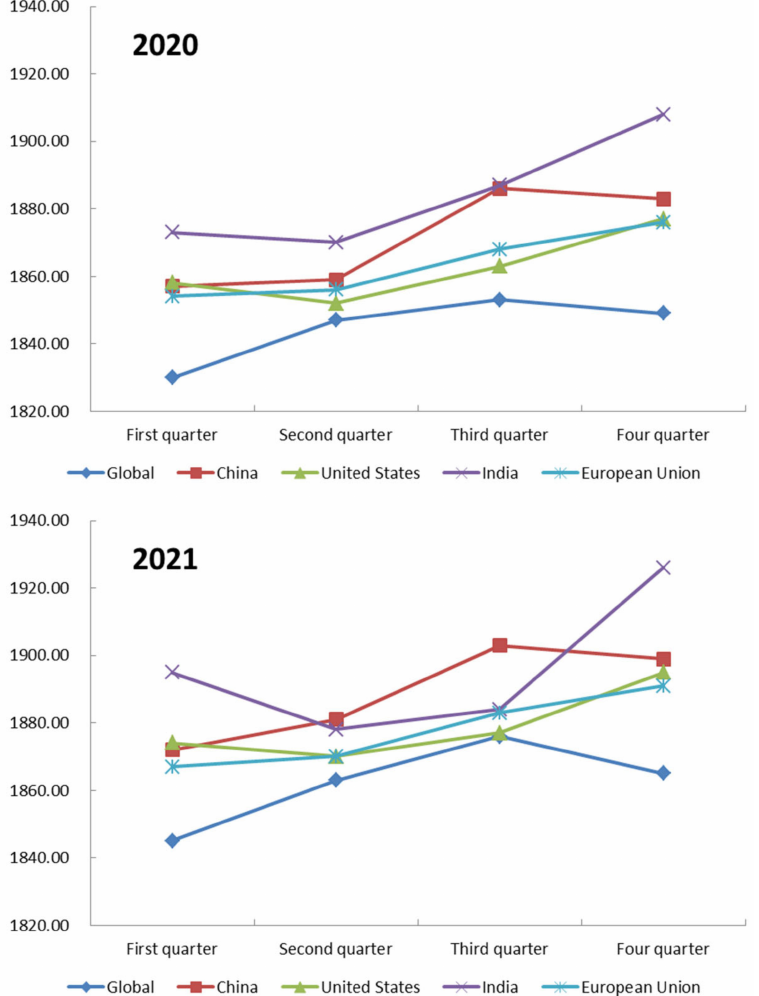
Figure 6. Trends of global CH 4 concentrations and major countries/regions in 2020 and